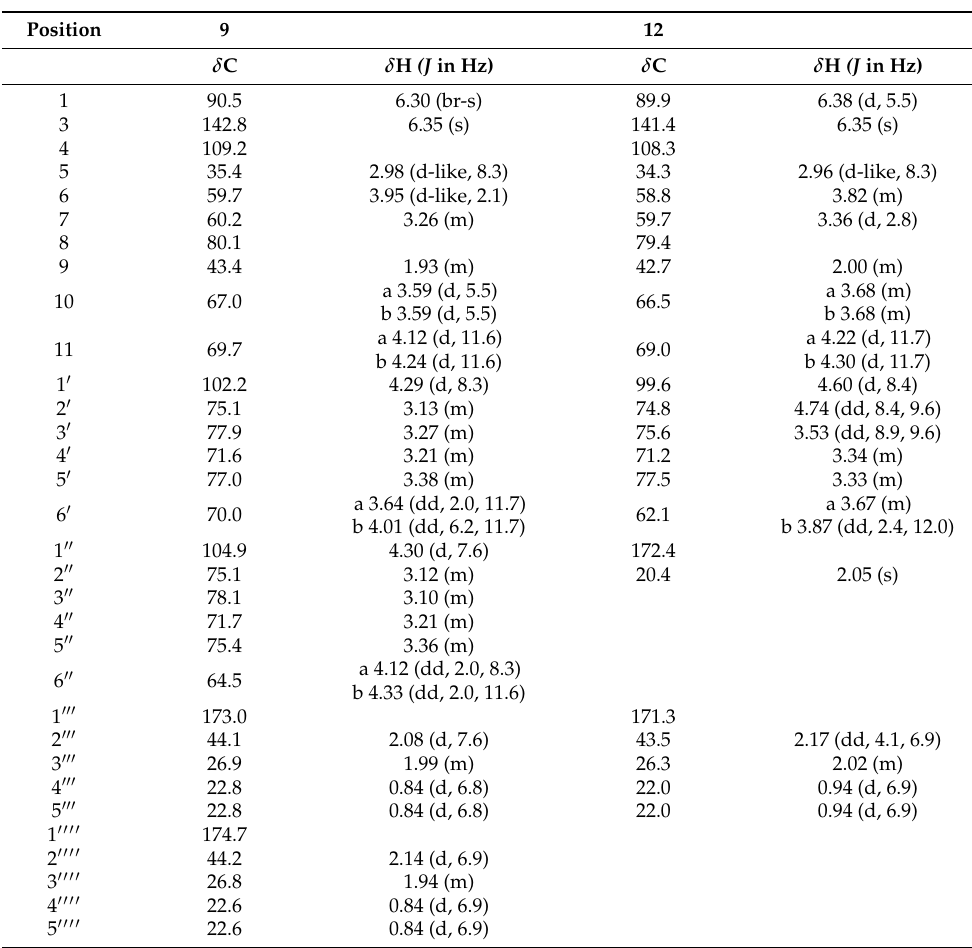
Table 3. 13 C (150 MHz) and 1 H NMR (600 MHz) data for valerianairidoids VI and VII ( 9 and 12 ) recorded in CD 3